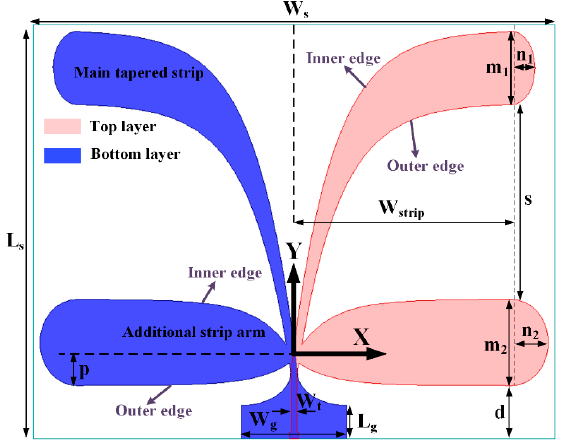
Figure 2. The proposed Vivaldi antenna configuration.